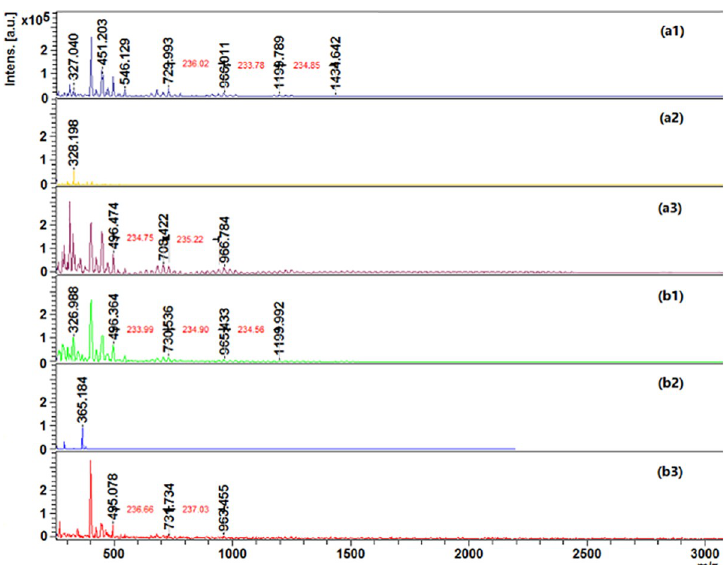
Fig 3. MALDI-TOF analysis of polyaniline polymerized by laccase: a1) aniline + laccase + HBT (WB); a2) aniline + without laccase + without HBT (WB); a3) aniline + without laccase + HBT (WB); b1) aniline + laccase + HBT (US); b2) aniline + without laccase + without HBT (US); b3) aniline + without laccase + HBT (US).